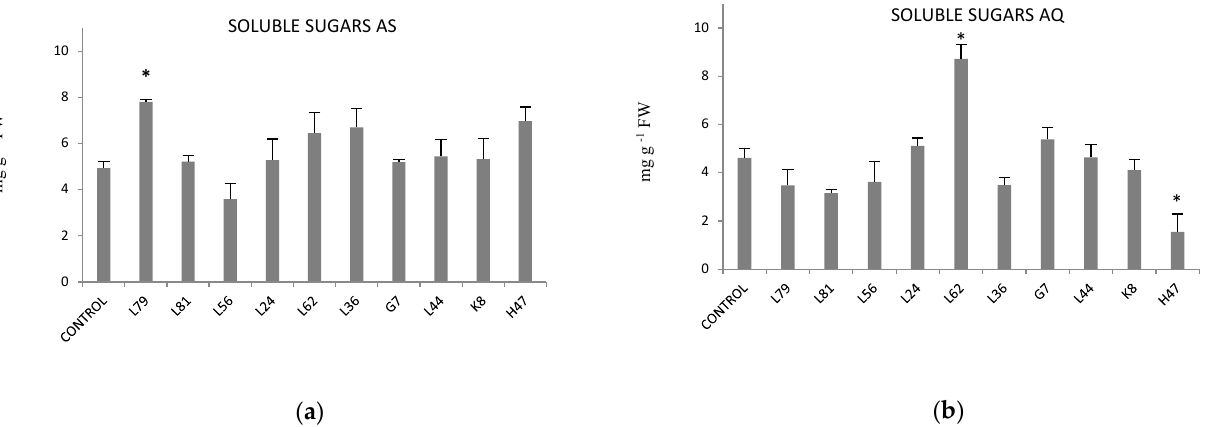
Figure 3. Soluble sugars (mg g − 1 FW) in ( a ) var. AS and ( b ) var. AQ olive leaves. Values are the average ± SE (n = 3). Asterisks (*) indicate significant differences with the controls according to T student ( p < 0.05).